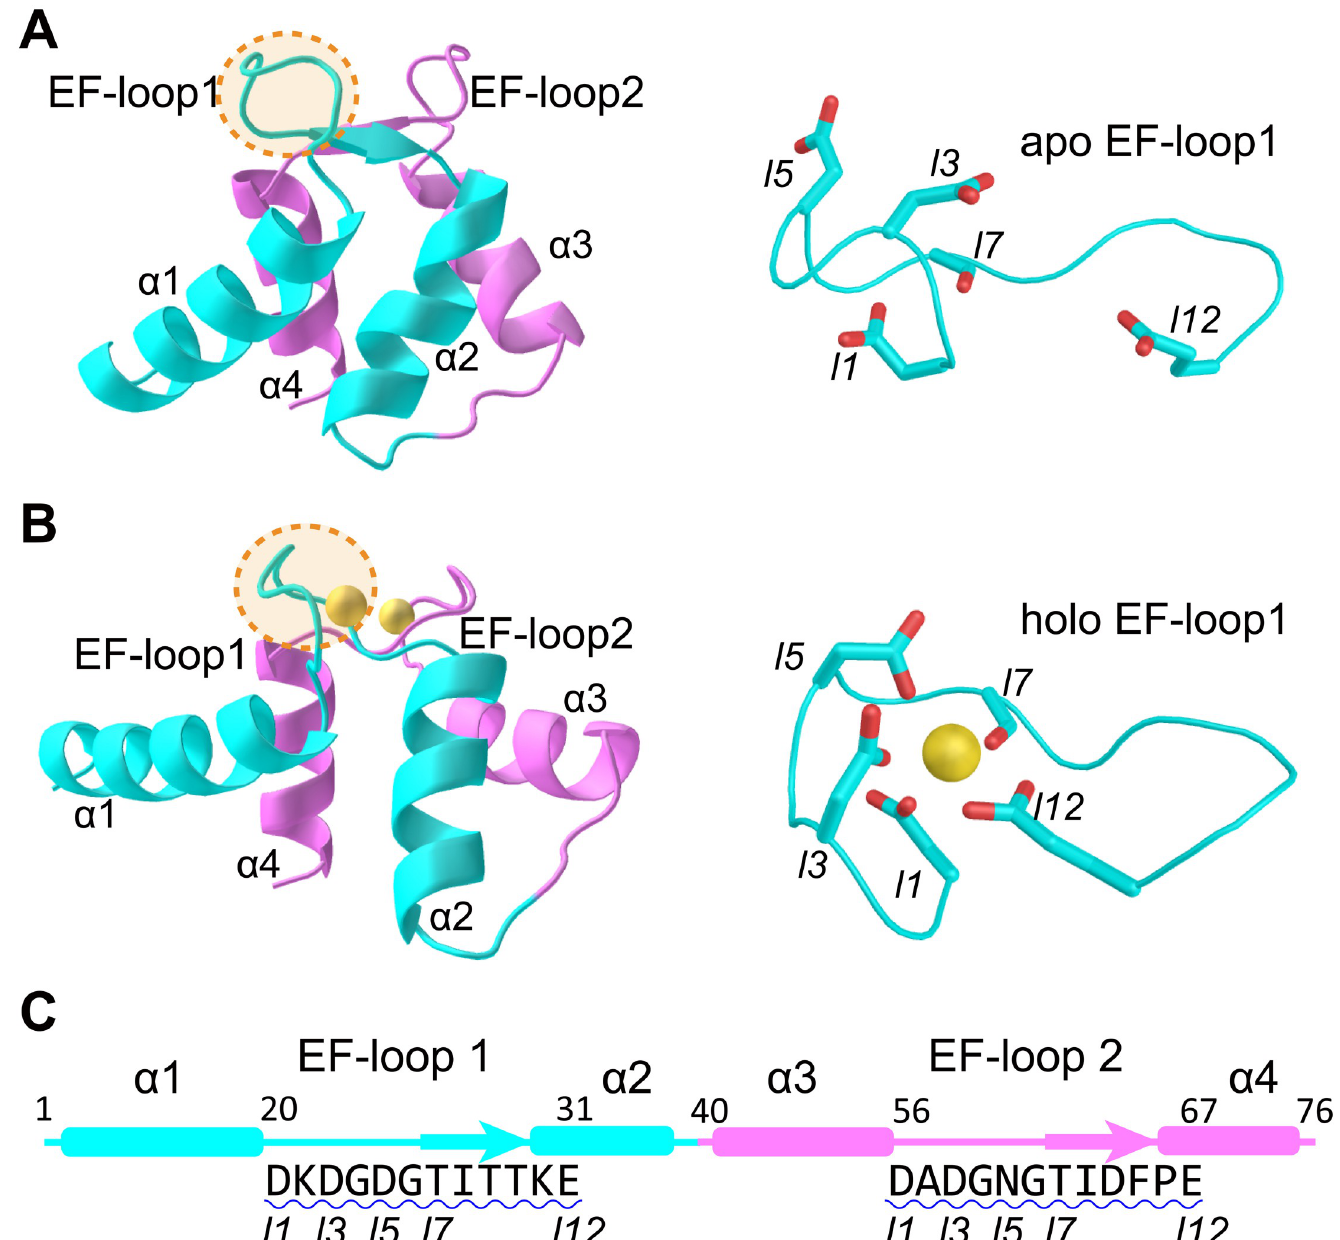
Fig 1. Structure and sequence of nCaM and the Ca 2+ binding EF-loops. (A, B) Structure of nCaM in the apo state (A) and holo state (B). Helix-loop-helix motifs α 1– EF-loop1– α 2 (cyan) and α 3–EF-loop2– α 4 (violet) comprise two EF-hands in the N-terminal domain of Calmodulin. Yellow spheres correspond to Ca 2+ ions. The details for one of the allosteric site in the loop region were also shown (right). (C) The sequence of nCaM and corresponding secondary structures. Ca 2+ binding loops are underlined with blue wavy lines. The native ligands are marked with “ ln ” to indicate their position in the